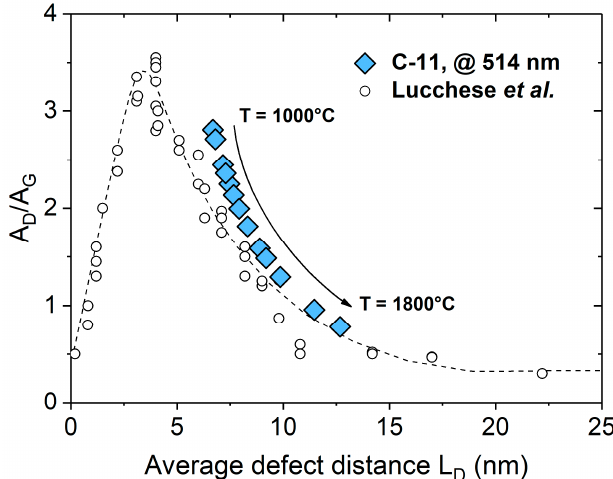
Figure 4. Evolution of the average distance between defects L D within the carbon of SiOC/C synthesized at different temperatures. The empty symbols correspond to a graphene-based material in which the disorder and defect concentration were altered upon argon ion bombardment [52].